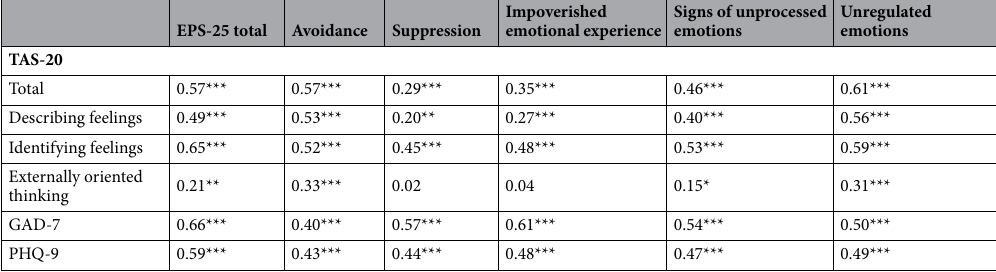
Table 2. Correlations between the Emotion Processing Scale (EPS-25) and measures of alexithymia (TAS-20), anxiety (GAD-7), and depression (PHQ-9) (N = 74) 28 . * P < 0.05, ** P < 0.01, *** P < 0.001.